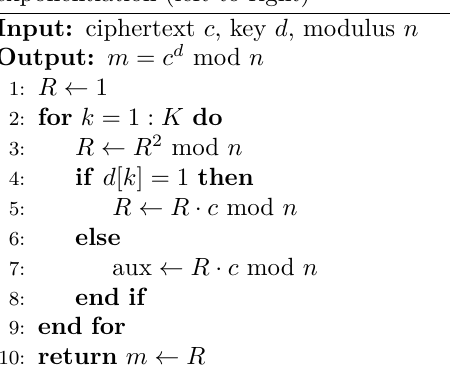
Algorithm 5 Square and multiply always exponentiation (left-to-right)